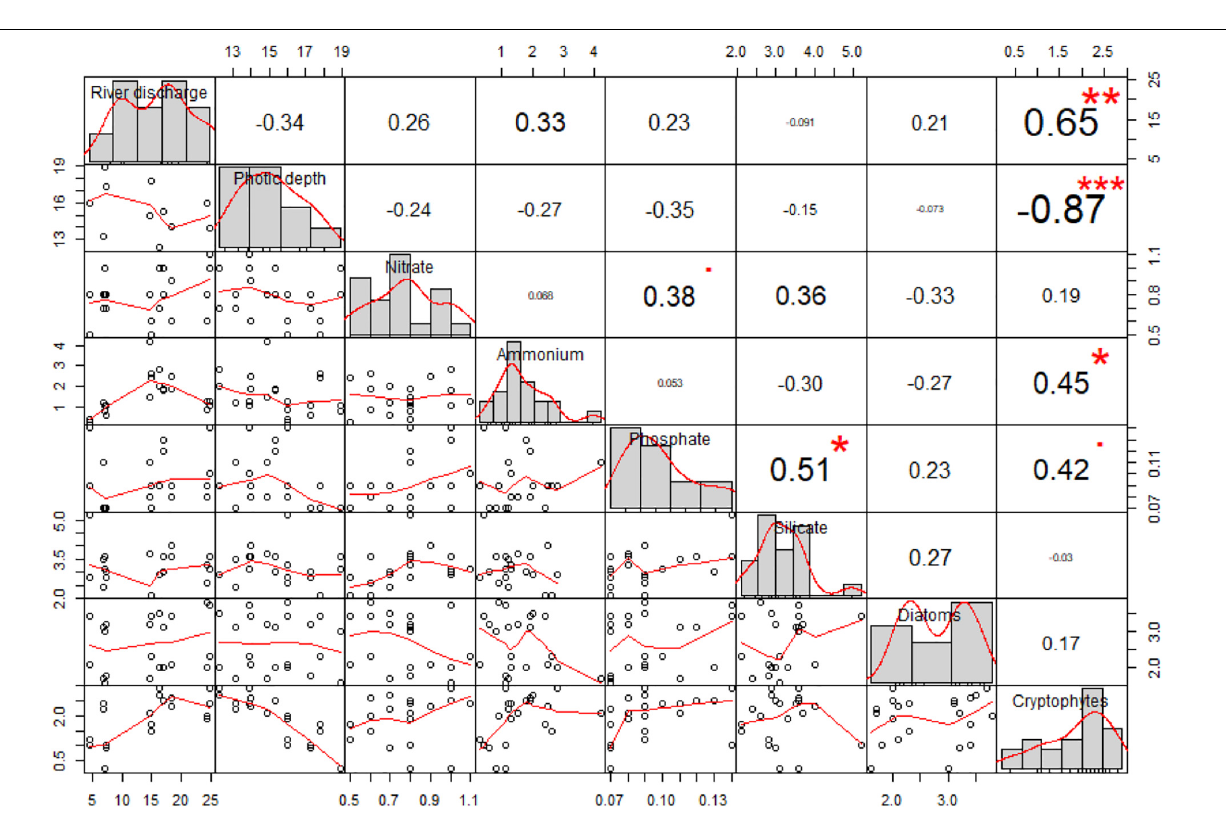
FIGURE 6 | Correlation matrix illustrating the correlation coefficients and regressions between two major phytoplankton groups (cryptophytes and diatoms) and environmental variables including river discharge, photic depth, NH 4 + and PO 43 - , and SiO 2 . The font size indicates the level of correlation coefficients and asterisks indicate the statistical significance (* p < 0.05; ** p < 0.01, and *** p <